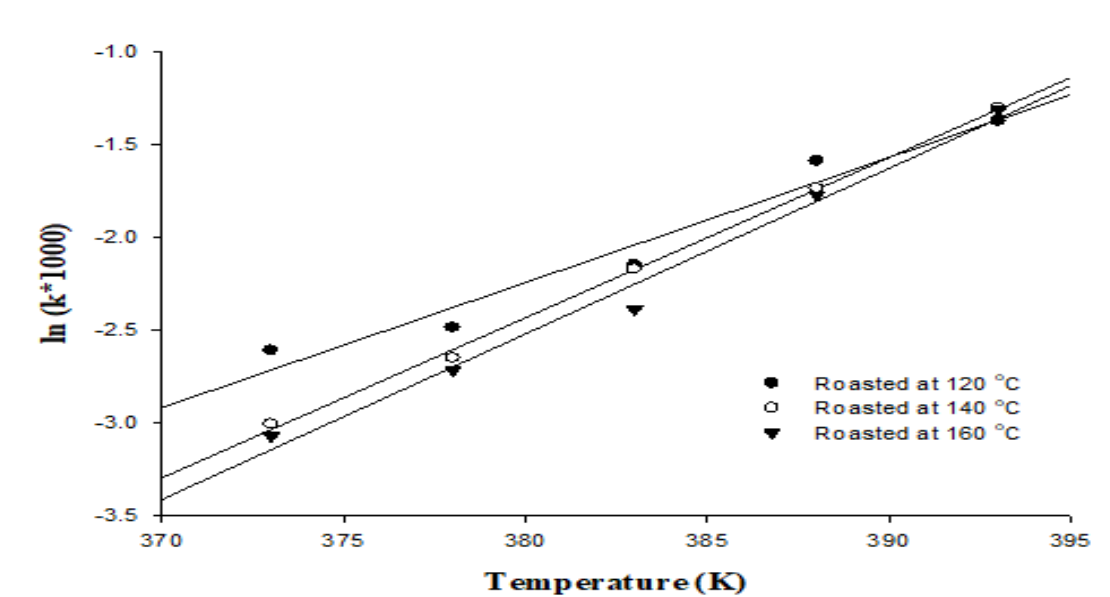
Figure 1. Semi-logarithmic relationship between k and temperature values for lipid oxidation of peanut oil. Table 5. Regression parameters for Arrhenius relationships between the reaction rate constant and the temperature for peanut oils.